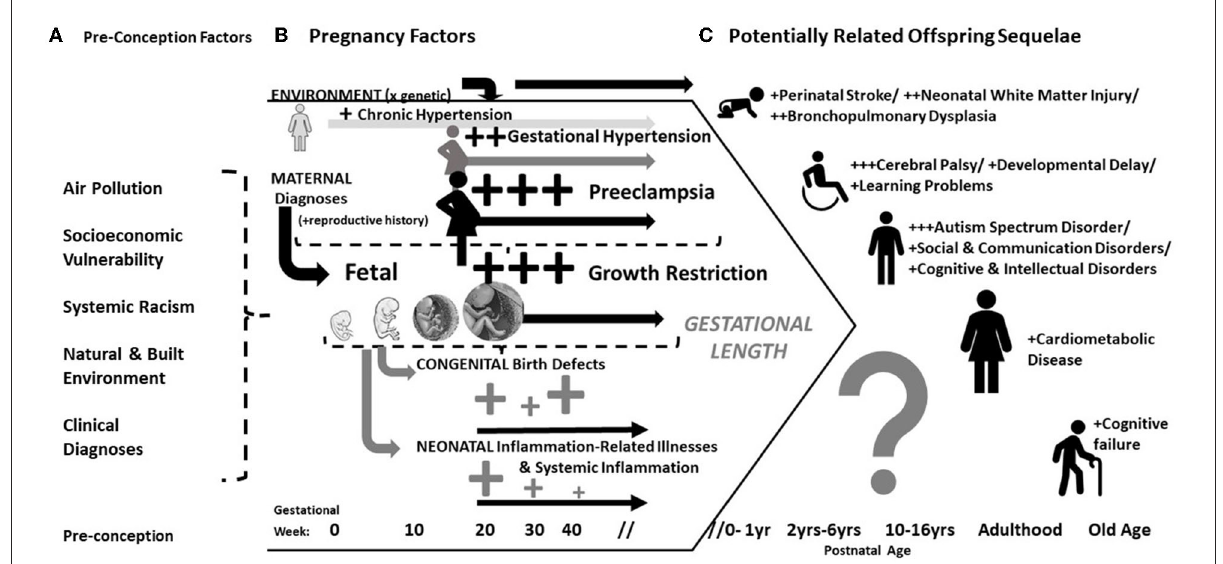
FIGURE1 Conceptual model of the antecedents, correlates and potential sequelae in offspring of mothers with preeclampsia. (A) Pre-conception/environmental factors are associated hypertensive pregnancy disorders and developmental disorders; (B) Either by shared underlying mechanism or confounding, preeclampsia is often associated with fetal/placental diseases, congenital anomalies detected at birth, and downstream inflammation-related illnesses after birth; (C) Largely depending on the length of gestation (and therefore co-occurrence with fetal growth problems), preeclampsia is associated with heightened risks of multiple developmental disorders and also chronic cardiovascular